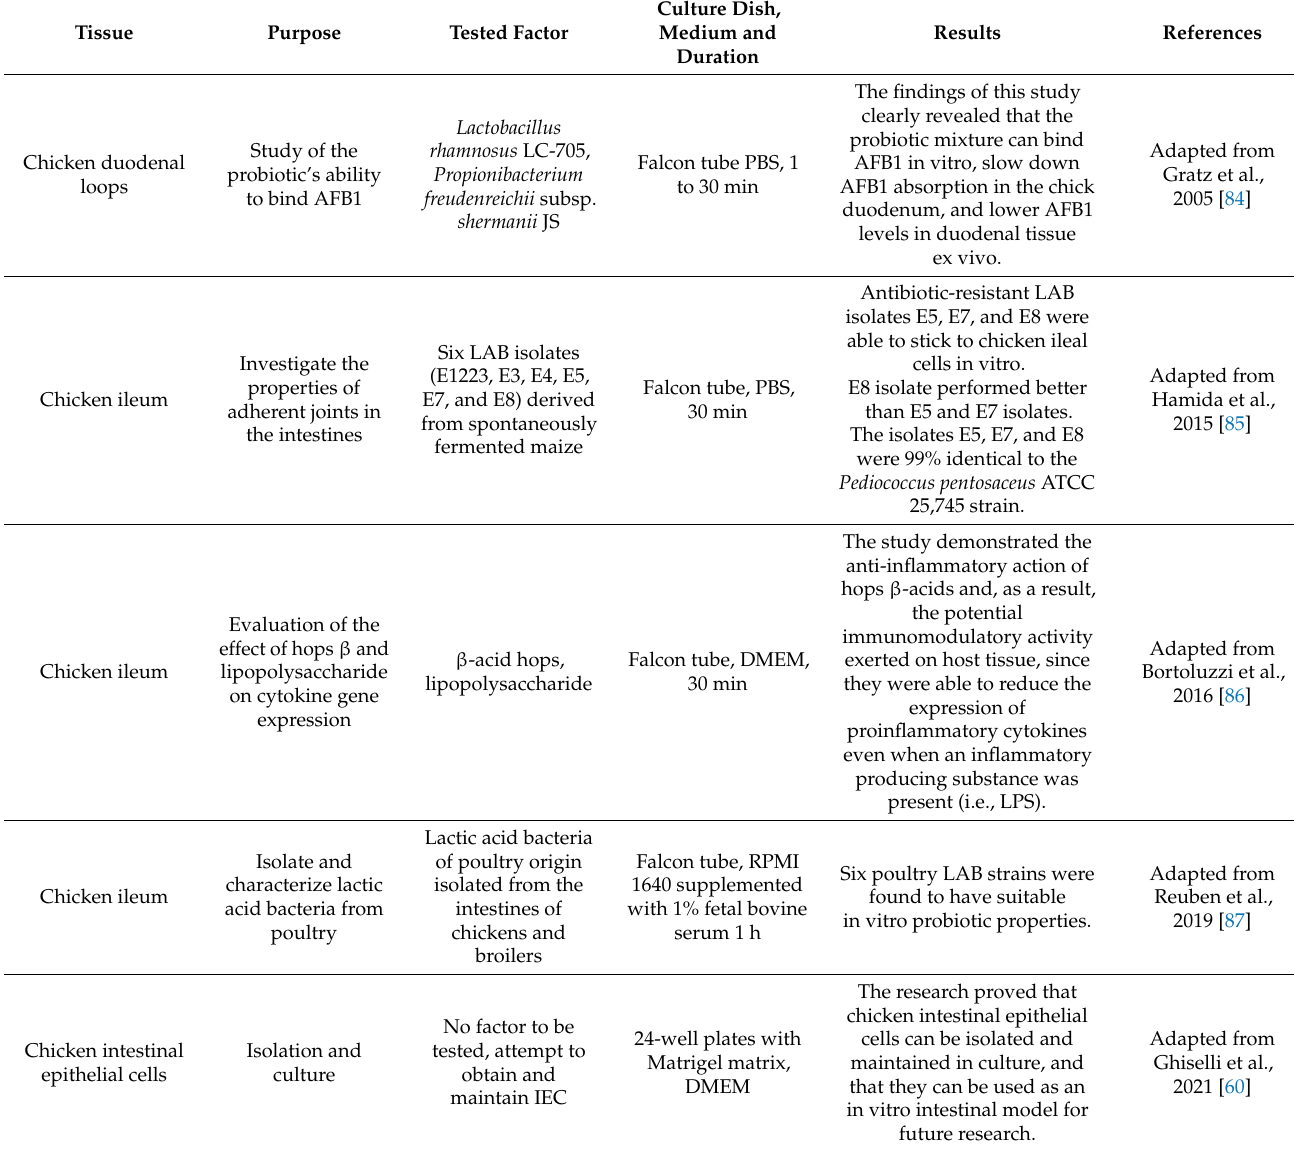
Table 4. Overview of the chicken ex vivo organ cultures derived from the intestinal tissue and culturing